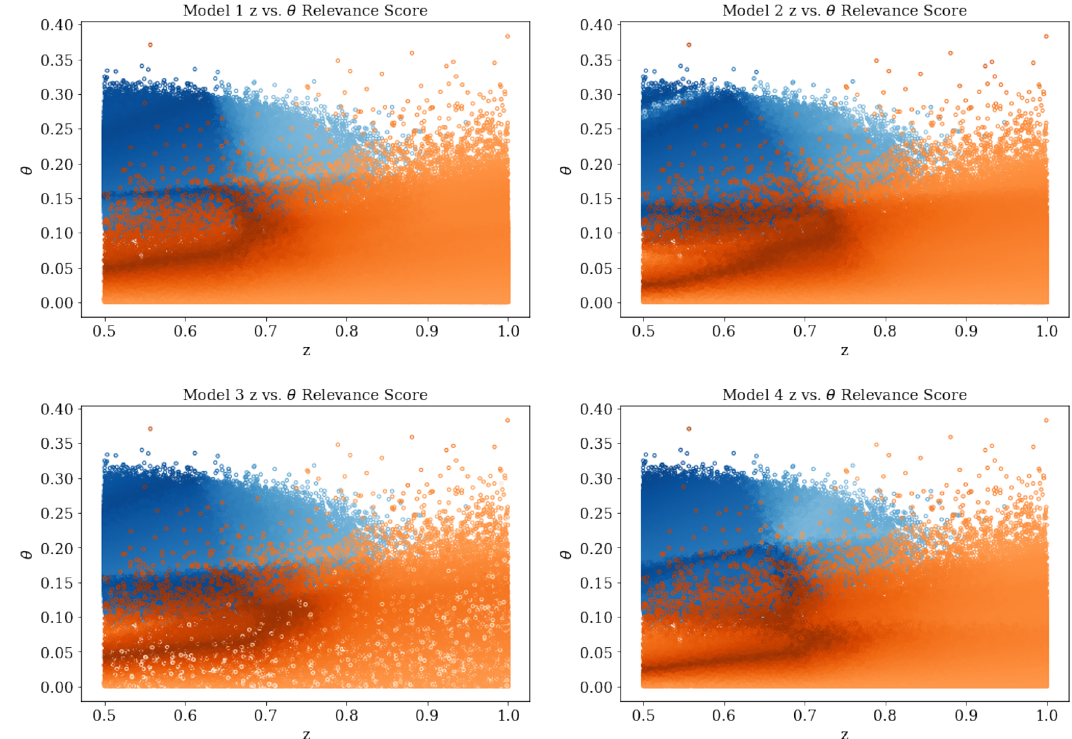
Figure 14. Relevance (LRP) scores for Toy Model 1D CNN for four separately trained models. The momentum fraction z is shown along the horizontal axis while the angle θ is shown on the vertical axis. The orange distribution is the background while the blue distribution is the signal. The intensity of the color indicates the summed LRP score, with darker colors representing more confident predictions of the